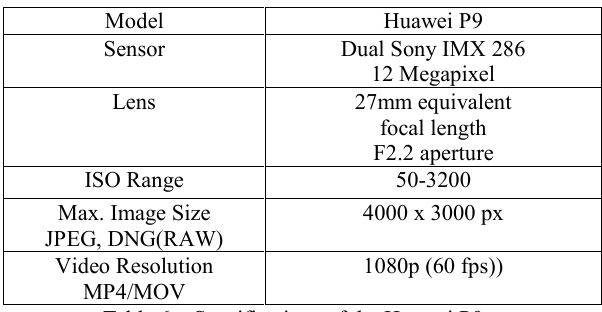
Huawei system a 12MP RGB main sensor is accompanied by a 12MP monochrome chip.